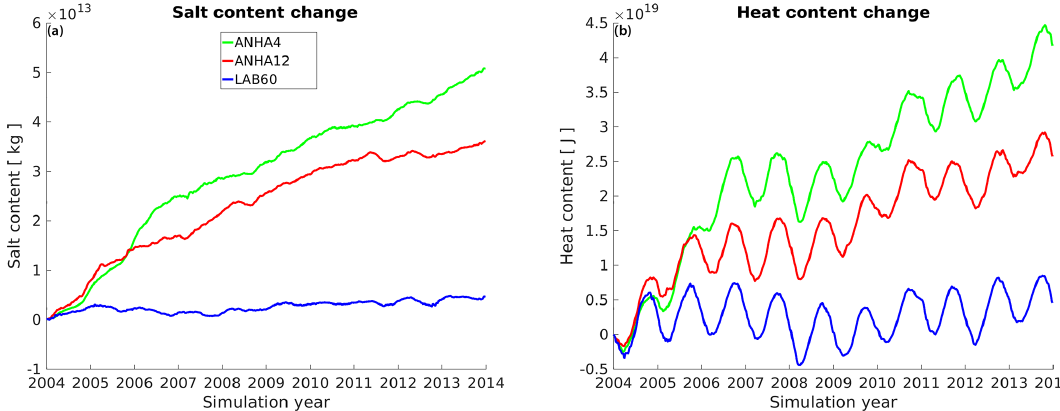
Figure 11. Numerical salt (a) and heat (b) drift in our three simulations as they evolve from 1 January 2004. The salt and heat content is calculated over the full ocean column within the polygon in Fig. 1c.